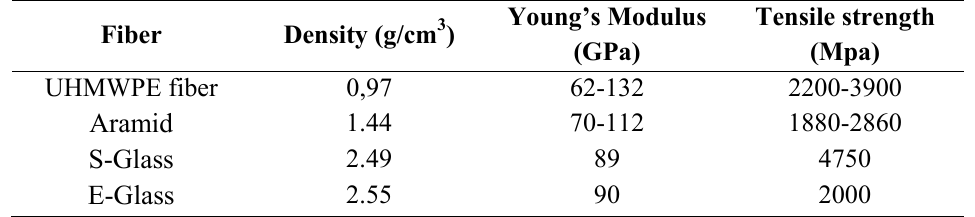
Table 2. Physical properties of glass fiber, aramid fiber, and ultrahigh-molecular-weight